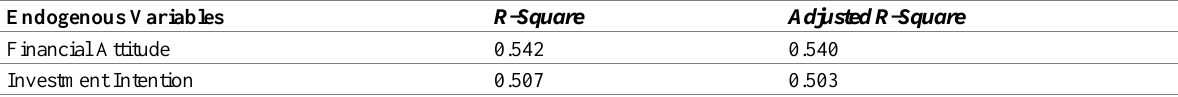
Table 3: R-Square